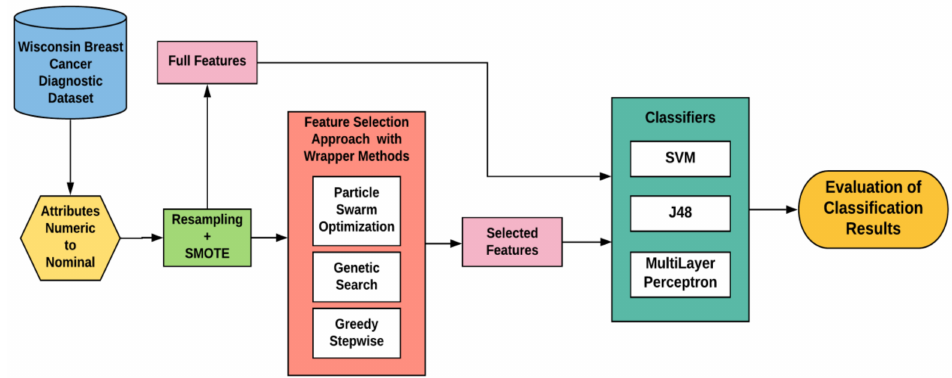
Figure 1. Proposed framework for breast cancer